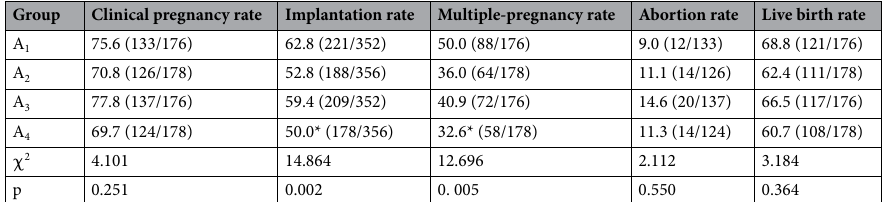
Table 2. Comparison of pregnancy outcomes between groups divided by serum estrogen levels on the endometrium transformation day [% (n/n)]. *Compared with other groups, P < 0.05.